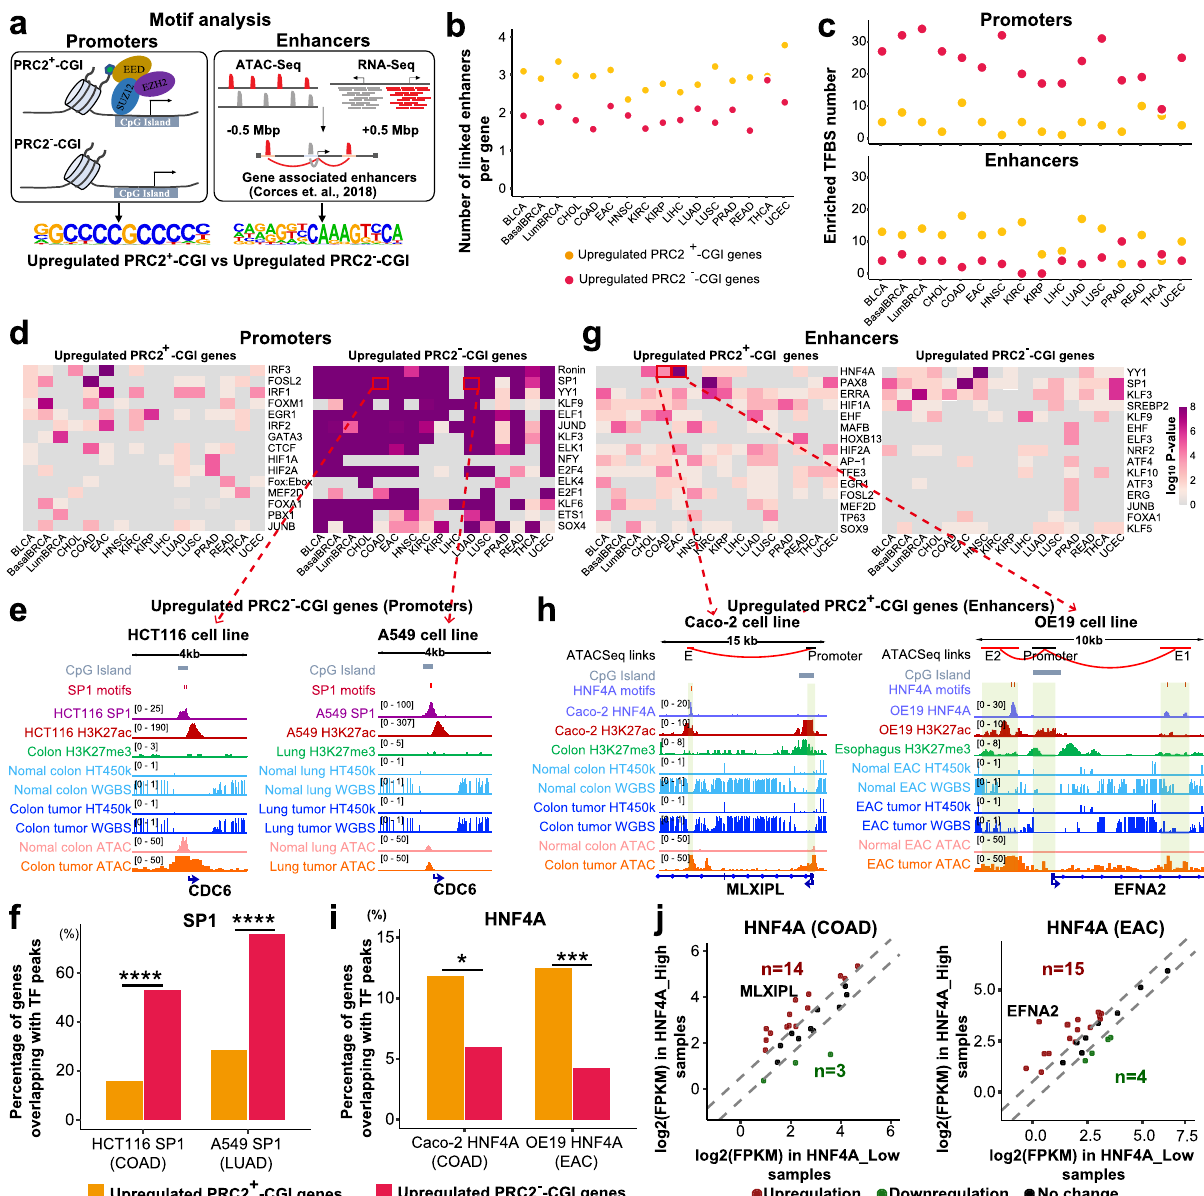
Fig. 5 Upregulated PRC2 + -CGI genes are linked to distal enhancers targeted by speci fi c transcription factor binding sites (TFBSs). a Sequence motif enrichment analysis was performed for upregulated PRC2 + -CGI and PRC2 − -CGI genes using either promoter or enhancer regions. The linked enhancers are from “ enhancer-to-gene links ” de fi ned by the TCGA ATAC-Seq consortium. b The number of linked enhancers per gene in both gene classes. c The number of signi fi cantly enriched TF motifs in promoter and enhancer regions. d The top 15 enriched TFs identi fi ed in promoter regions, selected by taking the most signi fi cant p -values across cancer types. e IGV plots showing the promoter region of CDC6 (a PRC2 − -CGI gene) with predicted SP1 motifs and occupied by SP1 in HCT116 COAD cancer cells (left) and A549 LUAD cells (right) by ChIP-Seq from the ENCODE project. f TF ChIP-Seq of SP1-binding overlapping PRC2 + -CGI vs. PRC2 − -CGI promoters. g The top 15 enriched TFs identi fi ed in enhancer regions, selected by taking the most signi fi cant p -values across cancer types. The one-sided hypergeometric test was performed in c , d and g and the enriched TFs with FPKM > 10 and unadjusted p -value < 0.01 in the corresponding cancer types were chosen. h HNF4A-binding motifs were predicted within distal enhancers for PRC2 + -CGI genes MLXIPL in COAD and EFNA2 in EAC, which were validated by HNF4A ChIP-Seq in COAD cells (Caco-2) and EAC cells (OE19). ChIP-Seq datasets were re-analyzed from GSE23436, GSE96069, E-MTAB-6858 and GSE132686. i TF ChIP- Seq of HNF4A-binding overlapping PRC2 + -CGI vs. PRC2 − -CGI enhancers, from the same COAD and EAC dataset above. j Expression differences between TCGA HNF4A-high and HNF4A-low EAC/COAD tumors for the HNF4A target genes having enhancers overlapped by HNF4A in EAC or COAD cells (from panel i ). High and low tumors were those in the upper and lower quintile of HNF4A expression. The cutoff for coloring is absolute fold-change ≥ 1.5. p -values in f and i were determined by a two-sided F i sher ’ s exact test. p < 0.0001****; p < 0.001***; p < 0.01**; p < 0.05*. The exact p -values are shown in Supplementary Data